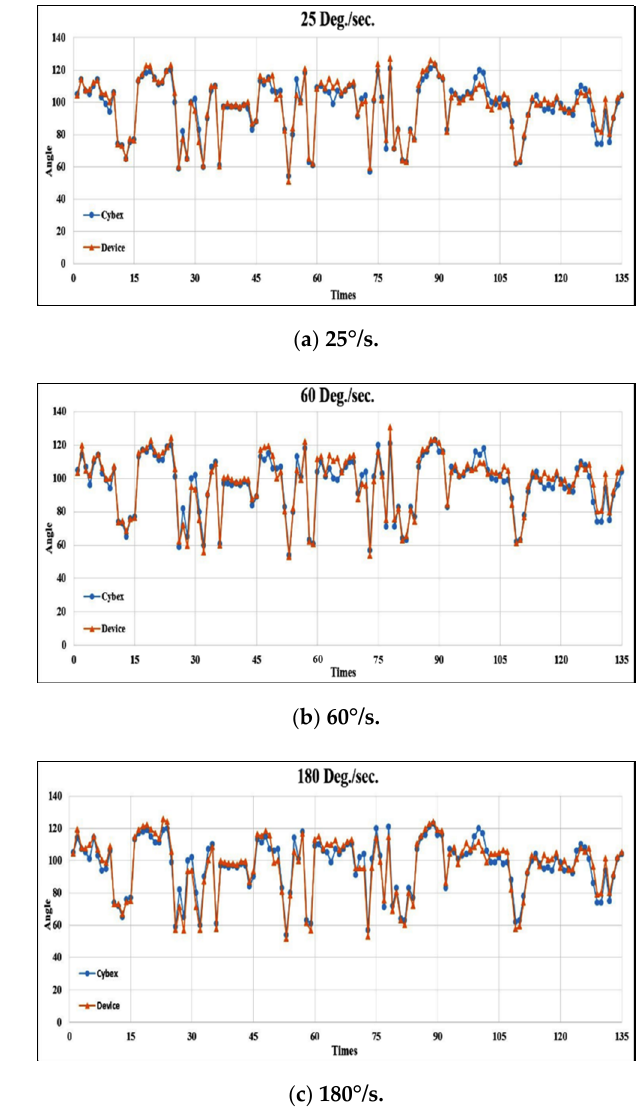
Figure 15. Comparisons of ROM for healthy control subjects at three speeds.